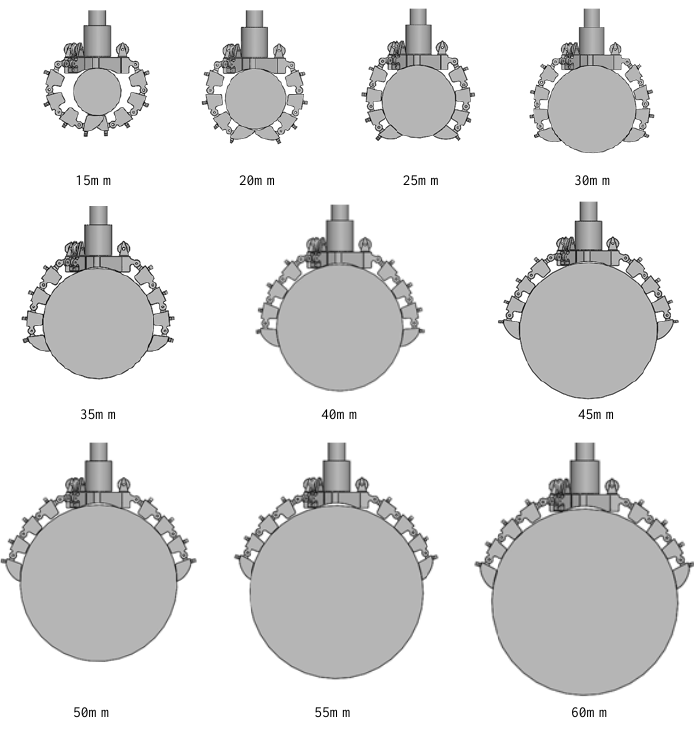
Figure 4. Long claw toe grasp results.